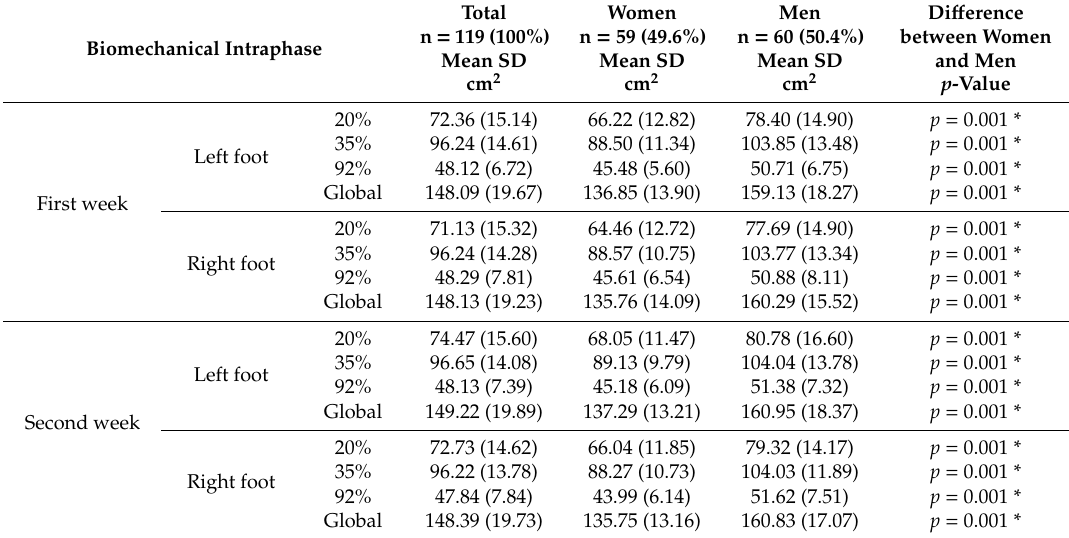
Table 5. Comparison of Women and Men for Contact Surface Areas, Second